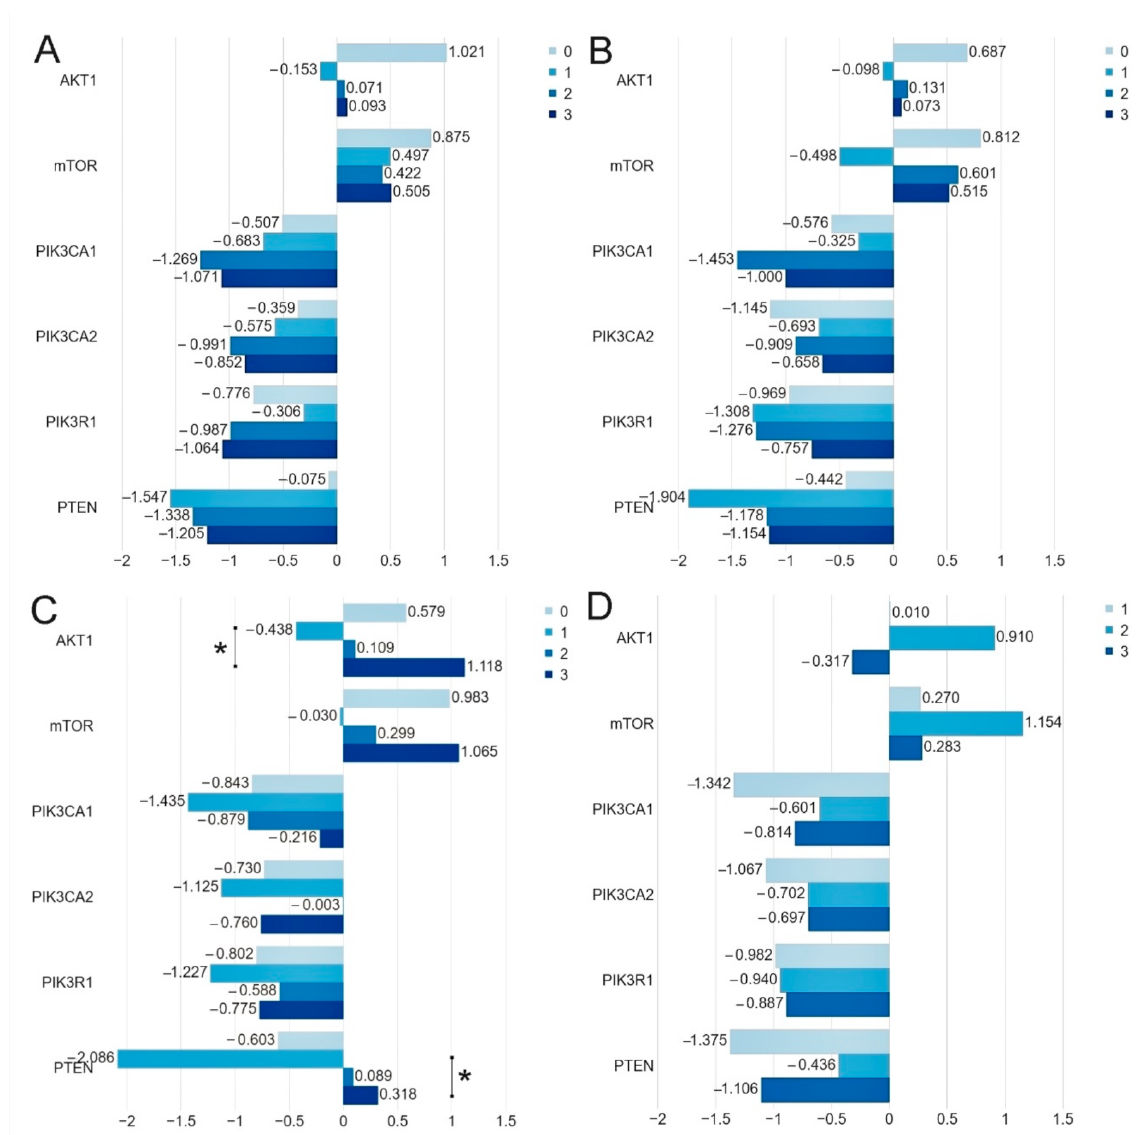
Figure 4. Comparison of the mean expression level (expressed in logRQ) of the studied genes depending on the: ( A ) ER-0 ( − ), 1 (1+), 2 (2+), 3 (3+); ( B ) PR-0 ( − ), 1 (1+), 2 (2+), 3 (3+); ( C ) HER2-0 ( − ), 1 (1+), 2 (2+), 3 (3+) status and ( D ) Ki-67 index-1 ( ≤ 10%), 2 (>10%- ≤ 50%), 3 (>50%- ≤ 90%) in the entire study group * p <